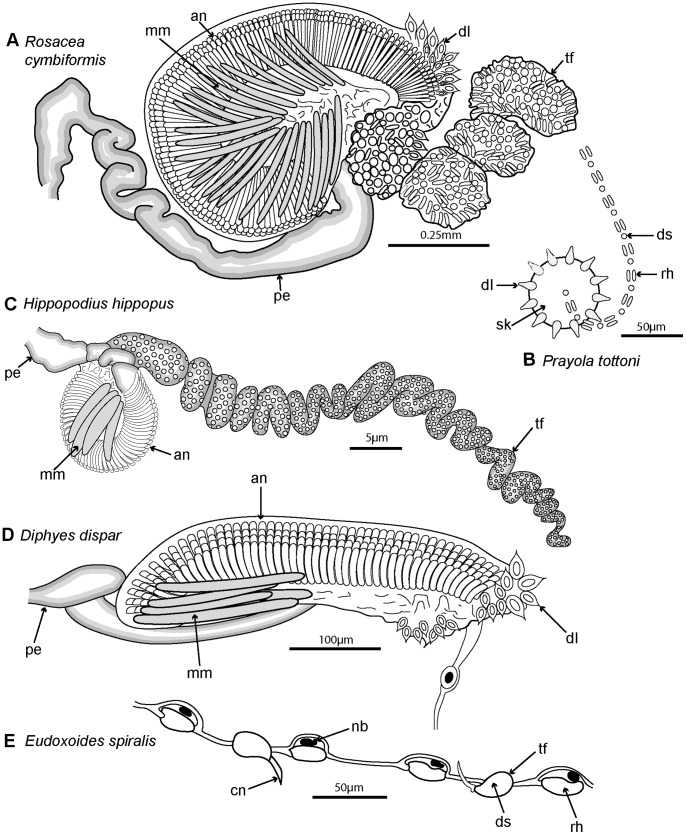
Schematic representations of tentilla from calycophoran siphonophores.A: typical prayid tentillum, Rosacea cymbiformis (re-drawn compilation from fig. 3E [67] and fig. 189 [150]); B: Sinker of Prayola tottoni (re-drawn from pl. 1, fig. 3 [133]); C: typical hippopodiid tentillum, Hippopodius hippopus (re-drawn from fig. 3C [67]); D: typical diphyomorph tentillum, Diphyes dispar (re-drawn from fig. 3I [67]); E: Detail of extended terminal filament of Eudoxoides spiralis (re-drawn from fig. 112 [122]). Labels: an – anisorhiza, cn – cnidocil; dl – large desmoneme; ds – small desmoneme; mm – microbasic mastigophore; nb – nematoblast; pe – pedicel; rh – rhopaloneme; sk – sinker; tf – terminal filament.